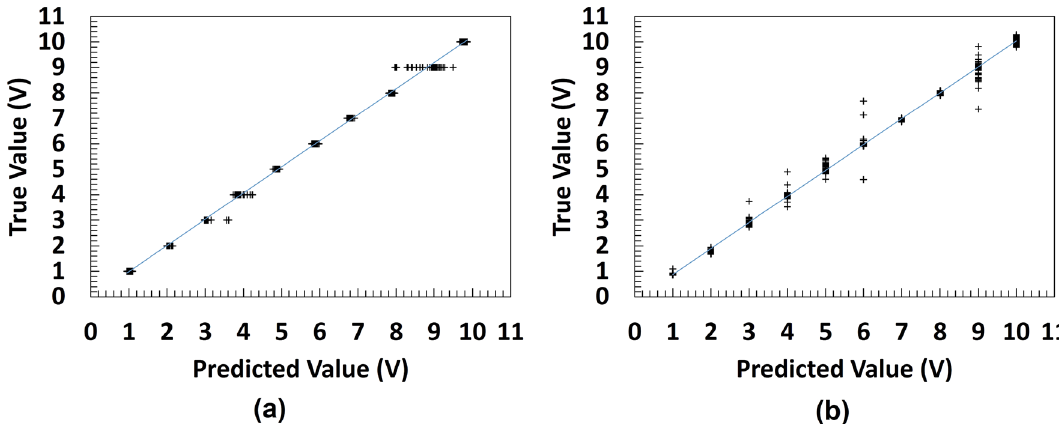
Figure 10. Line of best fit of the best deep regression models ( a ) AlexNet with ADAM ( b ) ResNet-50 with